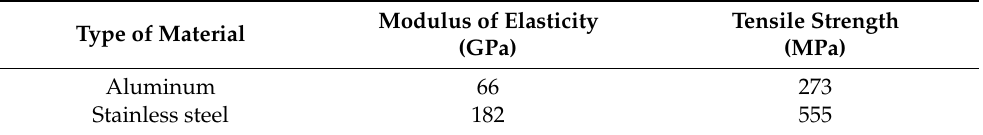
Figure 6. The tensile stress–strain curves: ( a ) aluminum curve; ( b ) necking behavior of aluminum sample; ( c ) stainless steel curve; ( d ) brittle fracture of stainless steel sample. Table 2. The mechanical properties of aluminum and stainless steel obtained by tensile